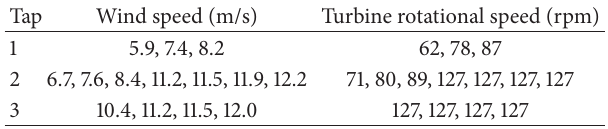
Table 5: Wind speeds and corresponding turbine rotational speed covered in the experiments and simulations.